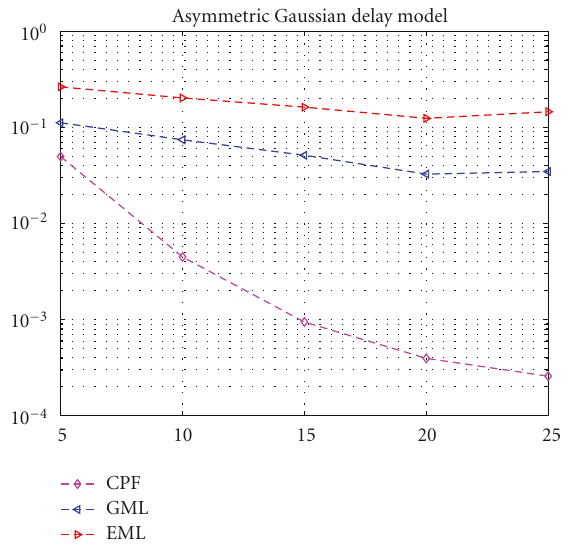
Figure 1: MSEs of clock o ff set estimators for asymmetric Gaussian random delays [ σ 1 = 1, σ 2 = 4].